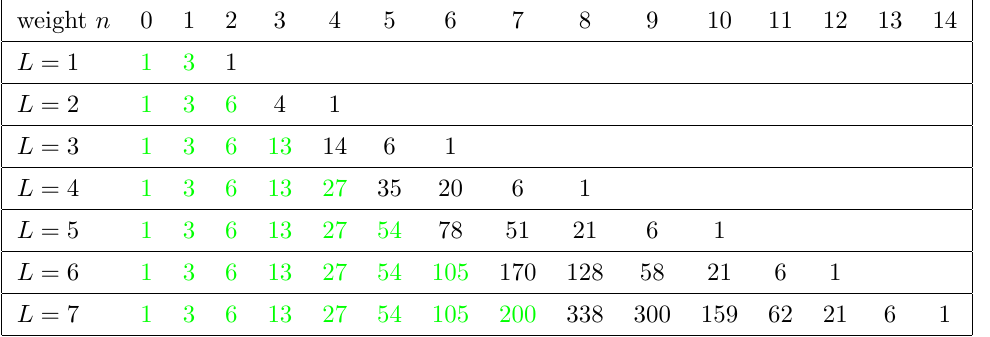
Table 8 . The number of independent f n; 1 ; 1 ; : : : ; 1 g coproducts of the MHV amplitudes through L = 7 loops. A green color indicates saturation.